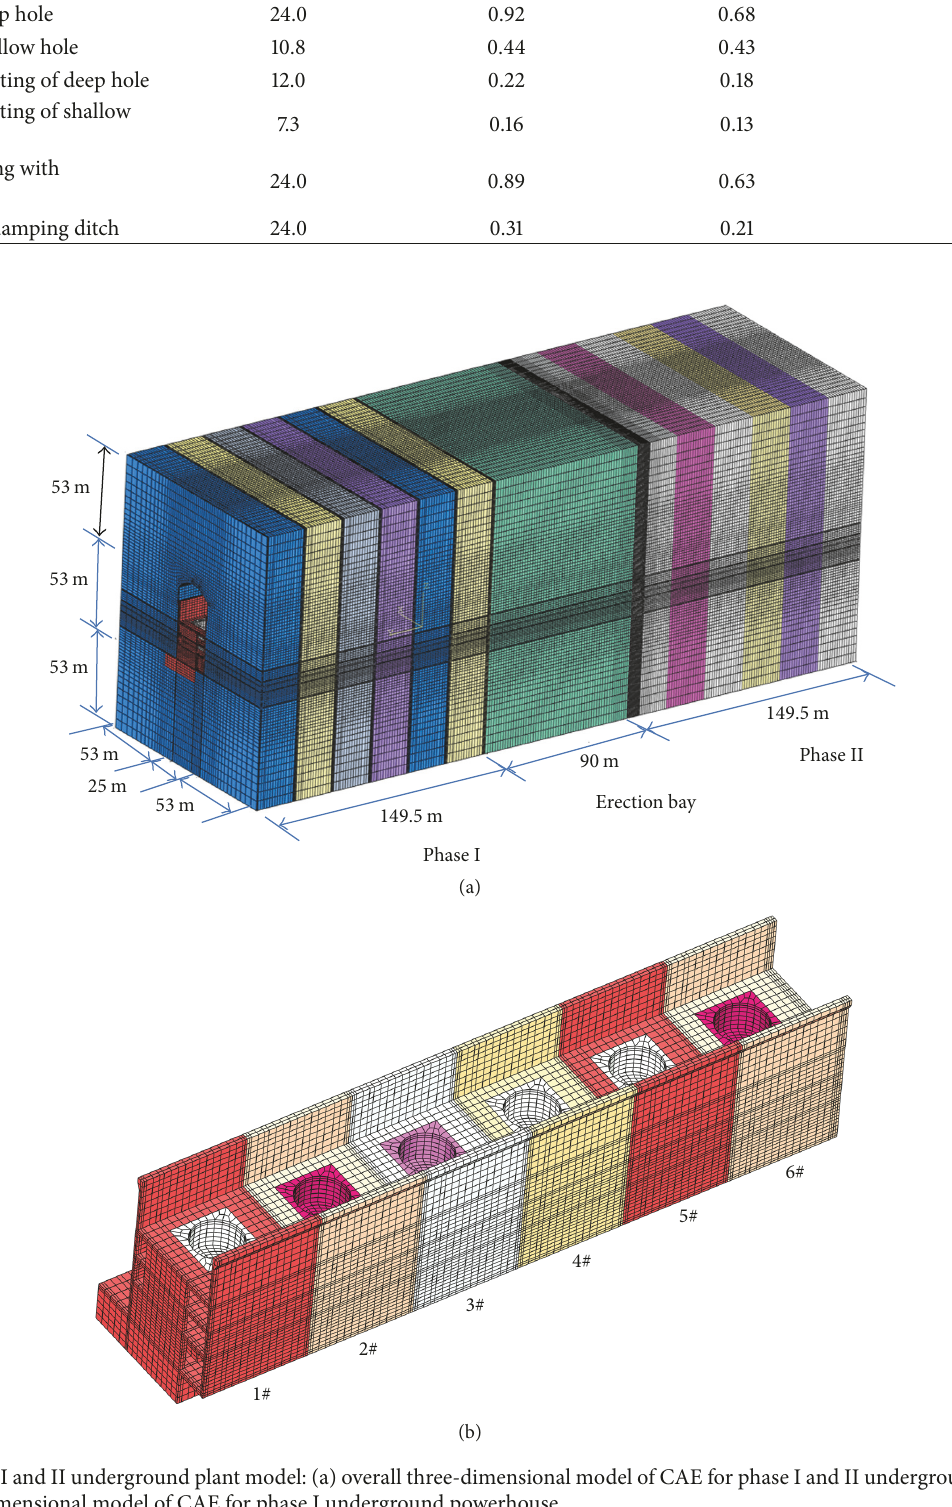
Figure 6: Phase I and II underground plant model: (a) overall three-dimensional model of CAE for phase I and II underground powerhouse and (b) three-dimensional model of CAE for phase I underground